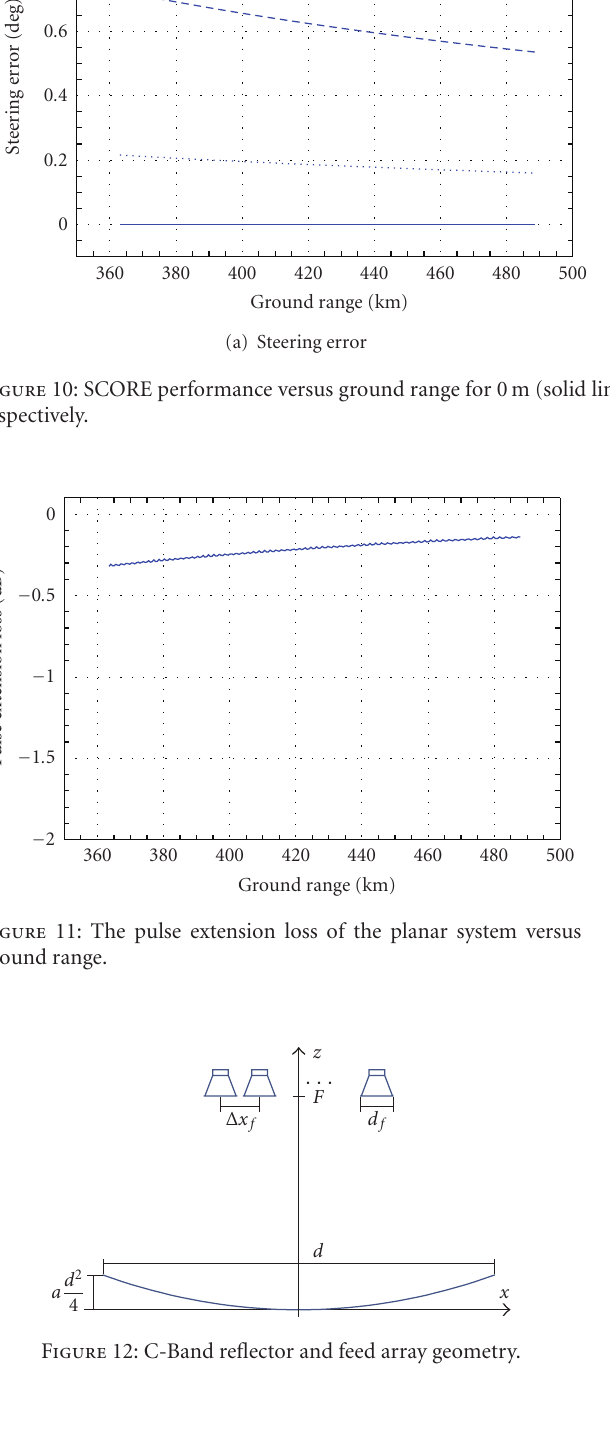
required to allow for the generation of multiple azimuth beams (cf. discussion in Section 2.2), since a single azimuth beam provides su ffi cient Doppler bandwidth to achieve the required azimuth resolution of 8 m (see Table